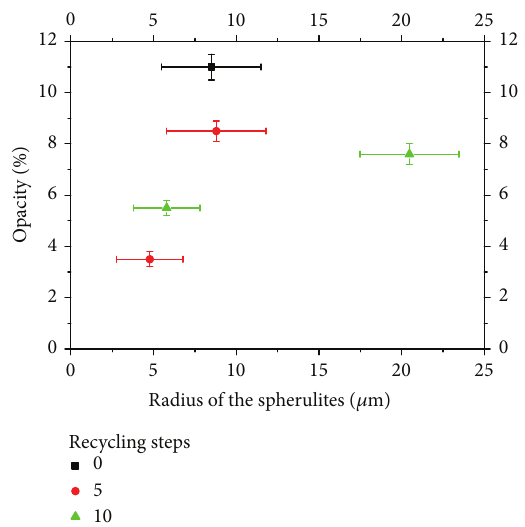
Figure 9: Dependence of the opacity of the films versus the radius of the spherulites for samples presenting an 𝛼 phase content between 0.4 and